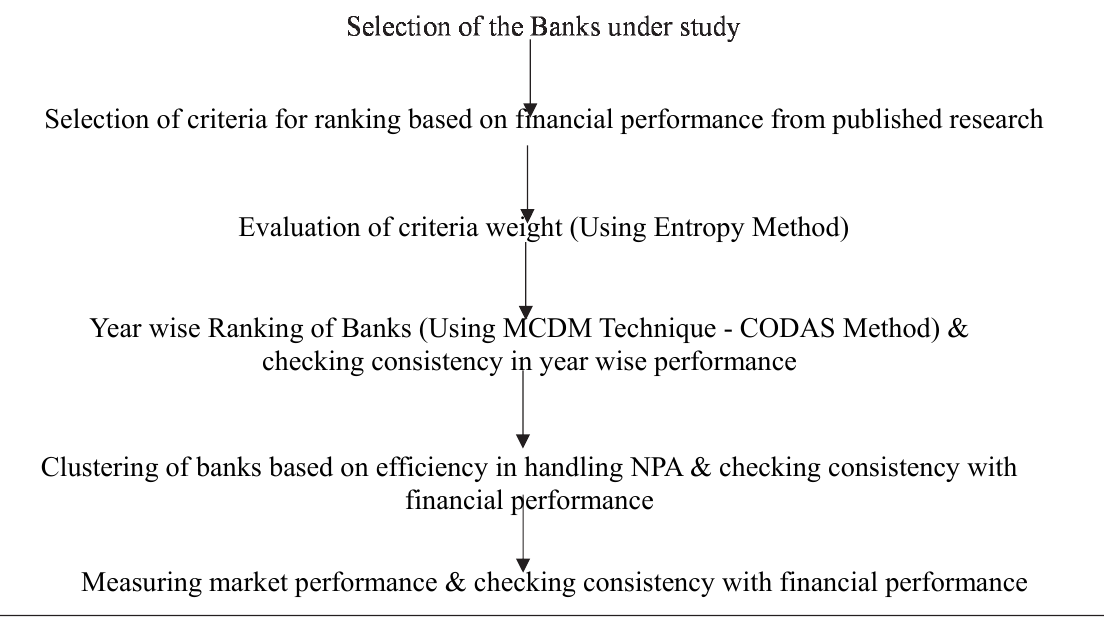
Fig. 1. Stepwise analysis scheme followed in this study (Source: